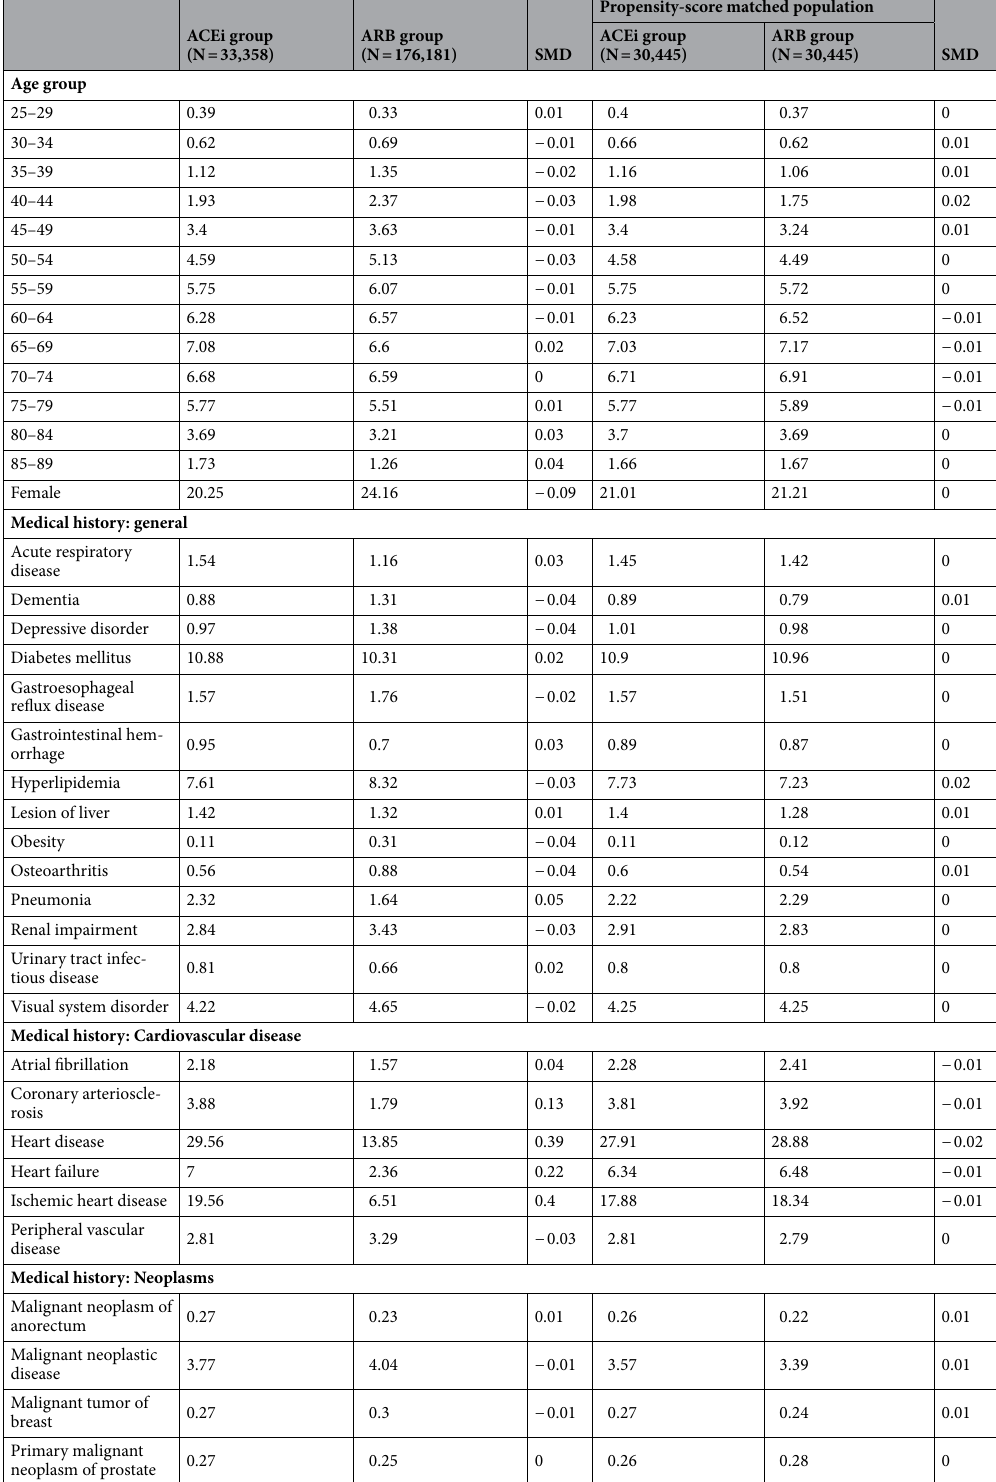
Table 1. Baseline characteristics of whole cohort. Data are presented as %. ACEi Angiotensin converting enzyme inhibitoir, ARB Angiotensin receptor blocker, SMD standardized mean difference. Current table showed the aggregated balance before and after matching only for limited covariates from 7